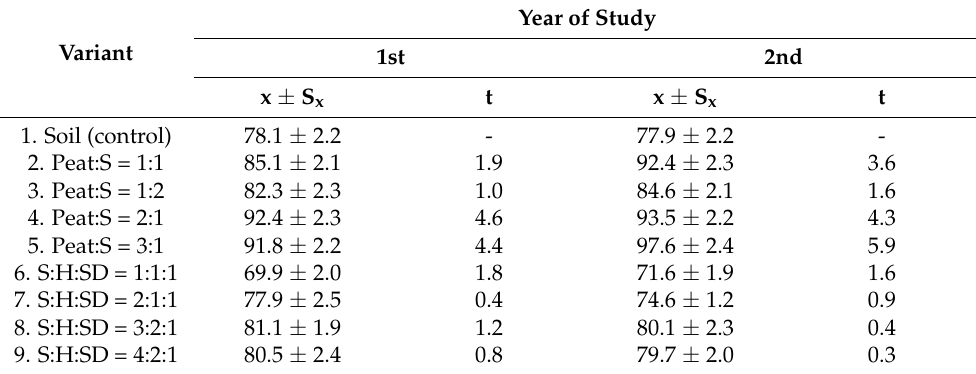
Table 1. Germination of English oak seeds in containers with different substrate composition (in %)— statistical data